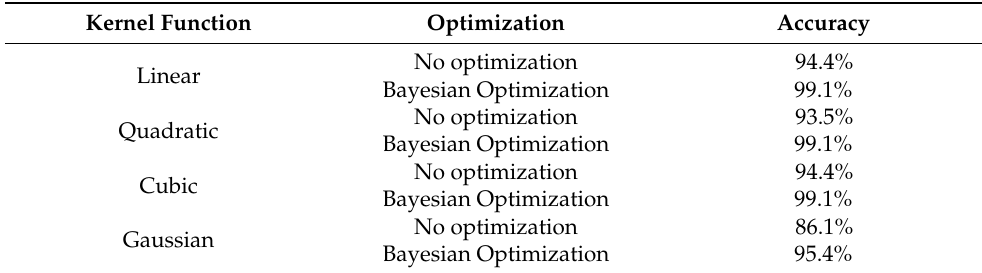
Table 2. Accuracy values obtained with ML based on different SVM classifiers.